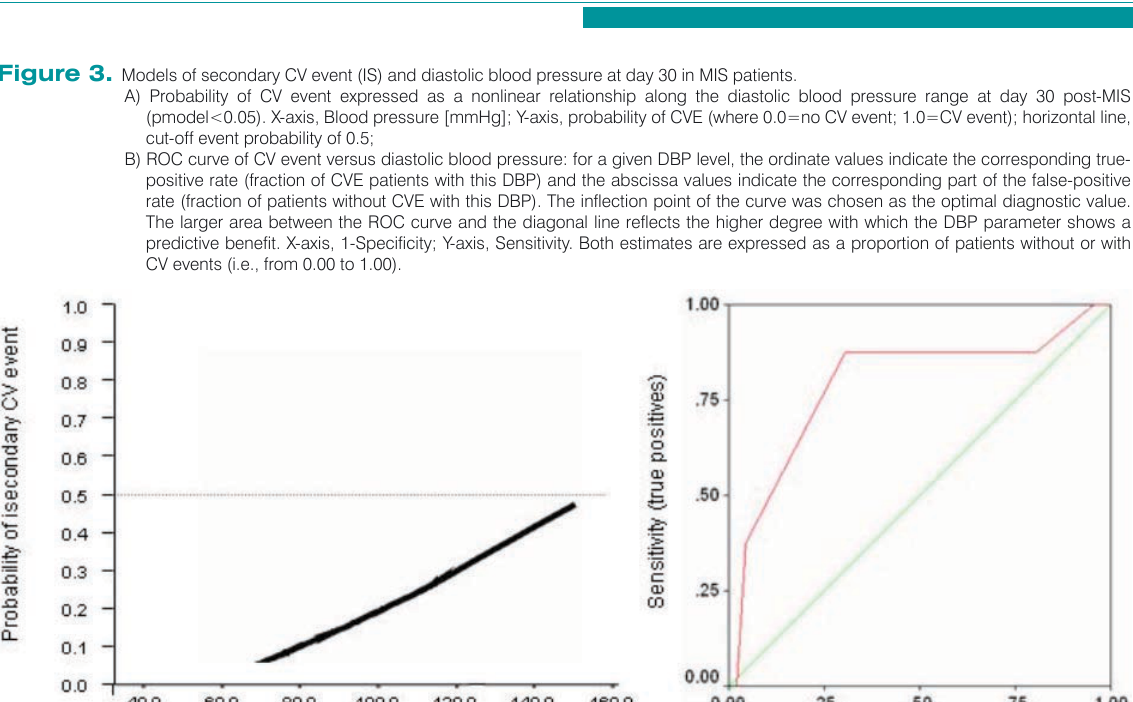
Table 2. Logistic backward conditional regression analysis for prediction of secondary CV event (p accuracy / concordance = 79.6%; ROC